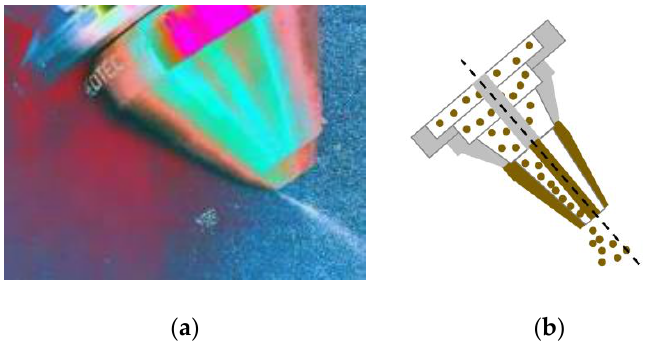
Figure 12. Gravitational effect on the continuous nozzle: ( a ) real; ( b ) schematic diagram.